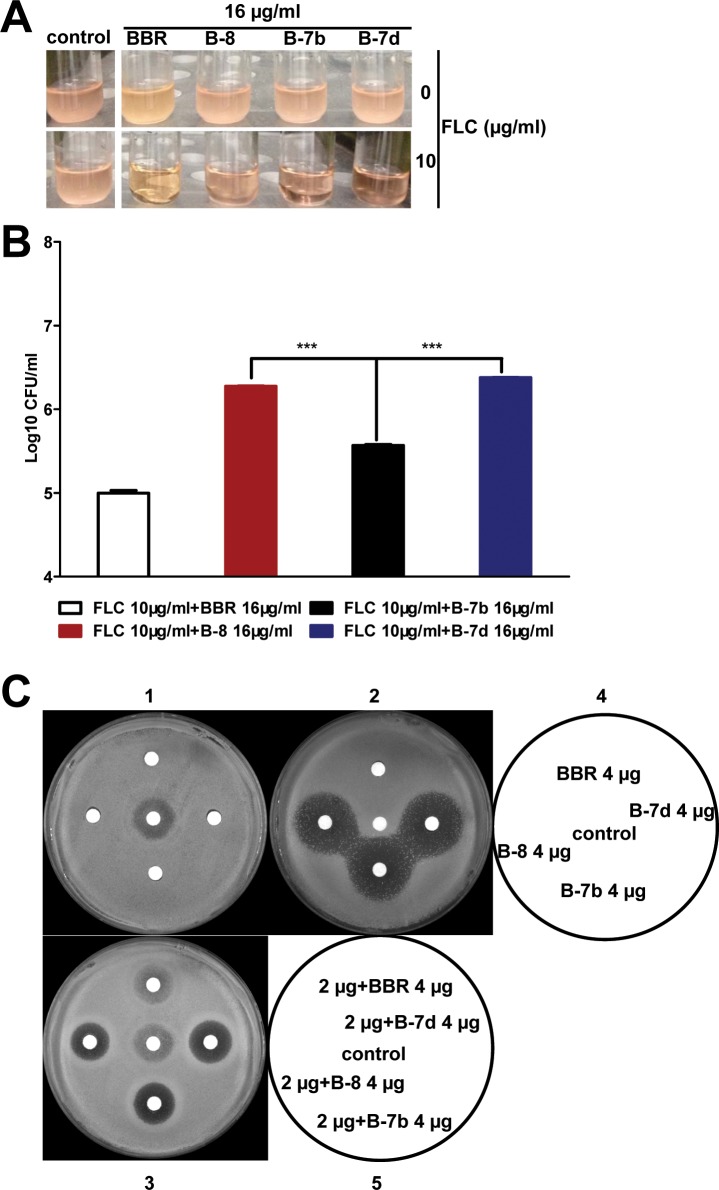
Growth condition of C. albicans 103 treated with FLC, BBR and different BBR derivatives.Exponetially growing FLC-resistant C. albicans 103 were treated with or without FLC (10 μg/ml), BBR (16 μg/ml) and different BBR derivatives (16 μg/ml B-8, B-7b, B-7d) alone or the combinations of FLC and BBR or BBR derivatives in a shaking incubator. (A) Pictures of the growth condition of C. albicans with an initial inoculum of 105 CFU/ml were taken after 24 h incubation. (B) The growth change of C. albicans 103 with an initial inoculum of 105 CFU/ml after 24 h. Aliquots were obtained at 24 h and serially dilutions were spreaded on agar plates. Colony counts were determined after 48 h incubation. (C) Agar disk diffusion assay of different compounds (BBR, B-8, B-7b and B-7d) combined with FLC against C. albicans 103. Panels 1 and 3 show agar plates, and panel 2 shows an agar plate containing 4 μg/ml FLC. Panel 4 describes the images for panels 1 and 2, which containing 4 μg of BBR, B-8, B-7b, B-7d and 2 μg of FLC or just DMSO as control per disc. Panel 5 describes the image for panel 3, the combination of 4 μg compounds (BBR, B-8, B-7b and B-7d) with FLC (2 μg) or FLC (2 μg) alone as control were contained in each disc.